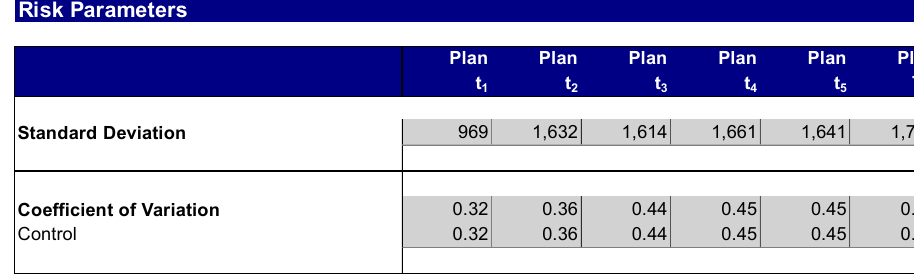
Figure 7. Calculation of the risk measures, standard deviation, and coefficient of variation.